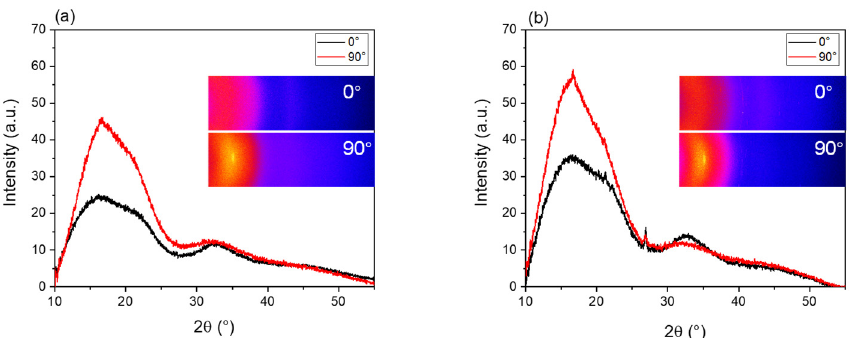
Figure 13. WAXD profiles at the azimuthal angles of 0 and 90° for raw ( a ) PLLA and ( b ) BC/PLLA fibers.